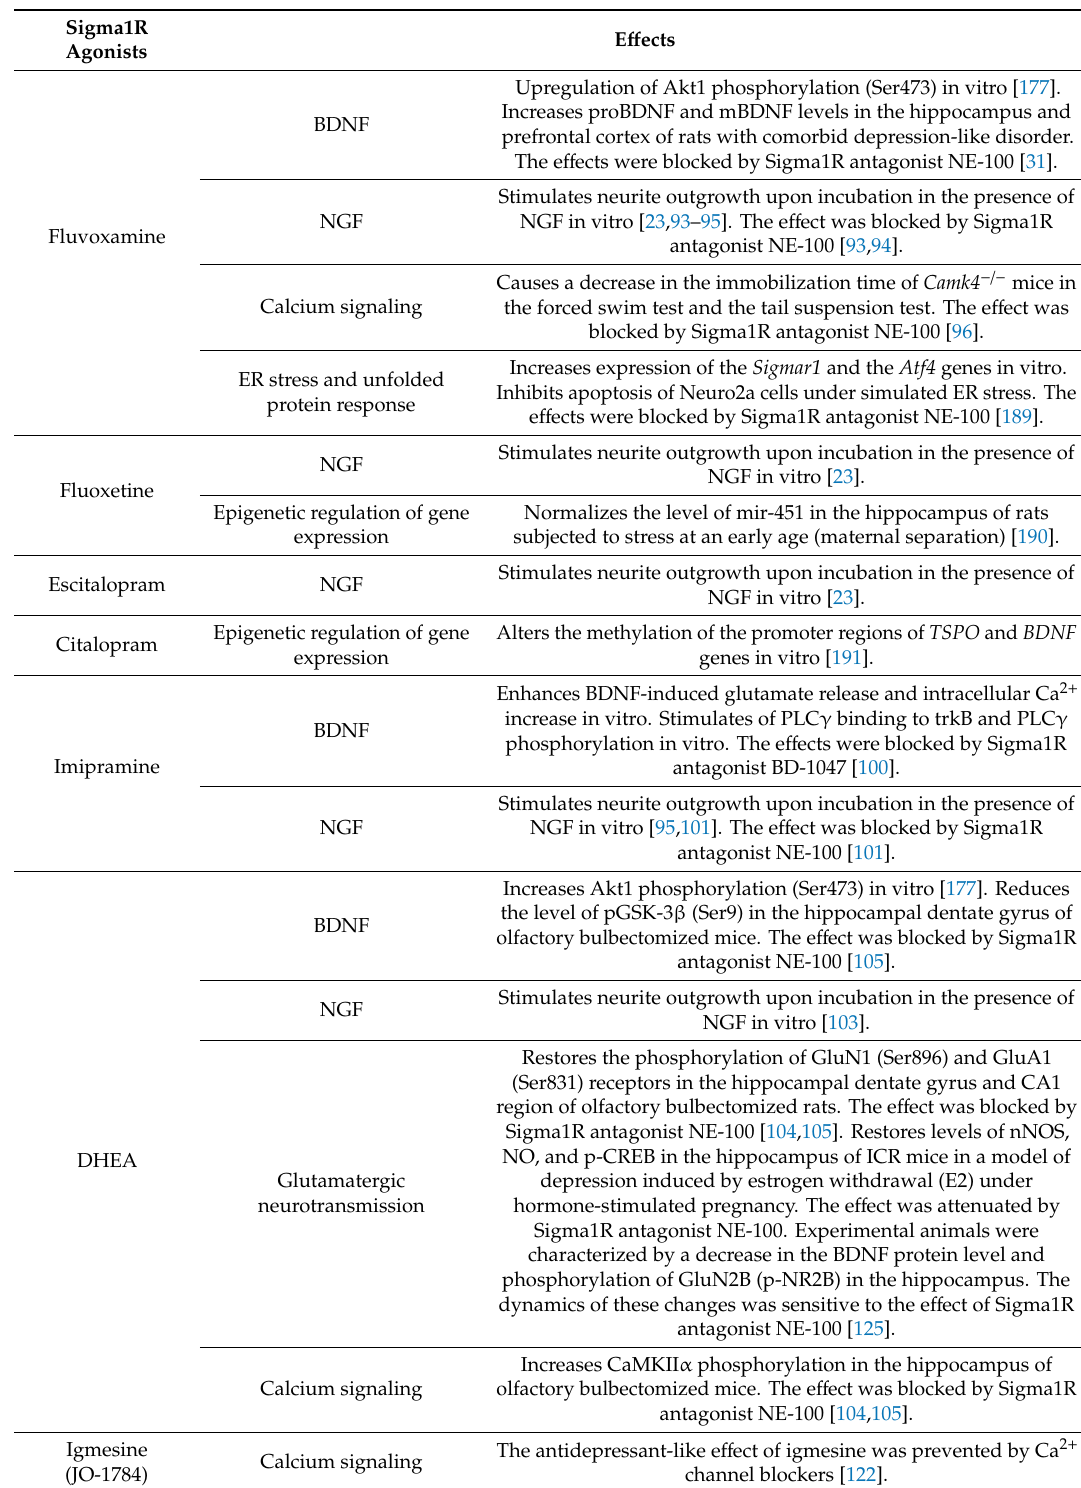
Table 2. The e ff ects of Sigma1R agonists associated with antidepressant-like activity. Sigma1R